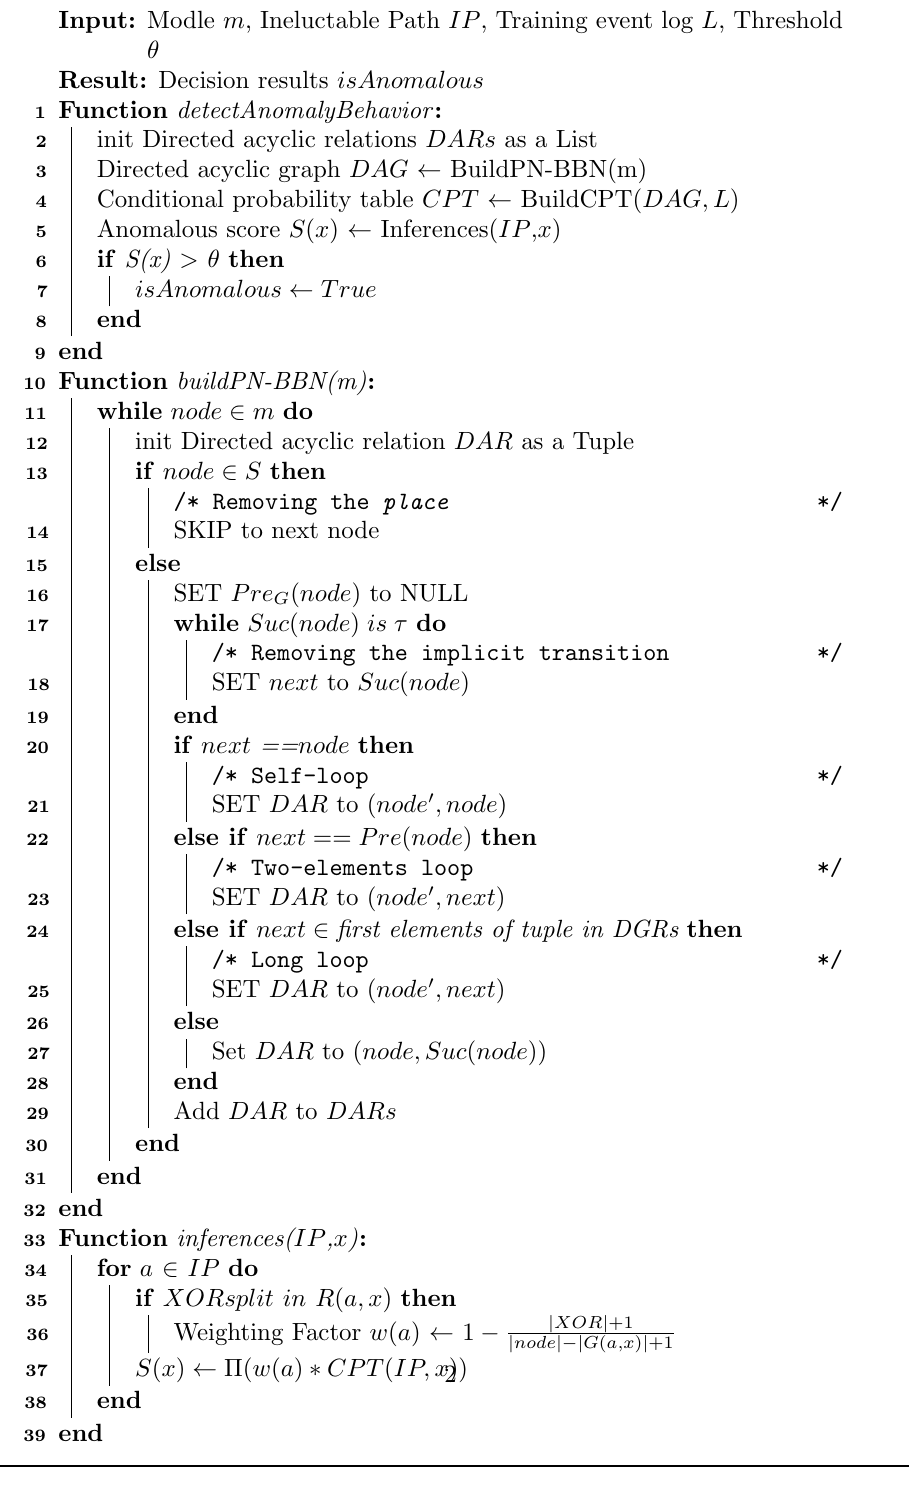
Algorithm 2: Anomalous behavior detection leveraging probabilistic inference.